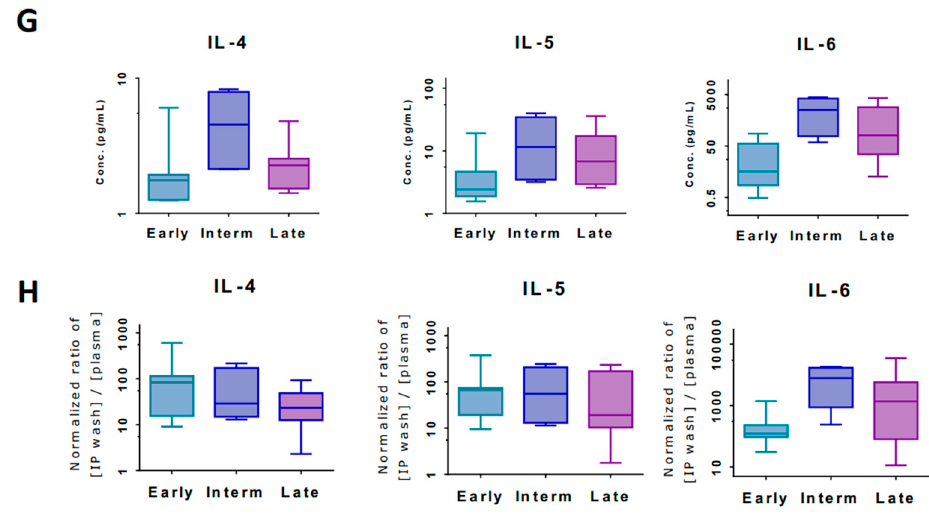
Figure 2. Immune gene and cytokine changes in IP fluid between early, intermediate and late time points during chemotherapy. ( A ) Heat map for DE genes ( q < 0.2) between early and late time points shows overall upregulation of immune genes. ( B ) Heat map for DE genes ( p < 0.05) between early and intermediate time points also shows overall upregulation early in chemotherapy. ( C ) Heat map for DE genes ( p < 0.05) between intermediate and late time points confirms more downregulation than other time point comparisons. ( D ) Venn diagram demonstrates DE genes that are shared be ‐ tween time comparisons ( p < 0.05). ( E ) Th2 immune genes ( IL17A, IL4, IL25, IL5 ) and B cell specific genes ( CD79B, CD19, AICDA, BLK ) show upregulation throughout chemotherapy, * denotes signif ‐ icant change between early and late time points, p < 0.05. ( F ) Conversely Th1 immune genes show downregulation, **denotes significant change between early and late time points, p < 0.05 and q < 0.2. ( G ) Concentration of select cytokines in IP washes, via MSD, showing upregulation at interme ‐ diate and late time points. ( H ) Normalized ratios of cytokine concentrations in IP wash divided by concentrations found in plasma (the latter also detected by MSD).